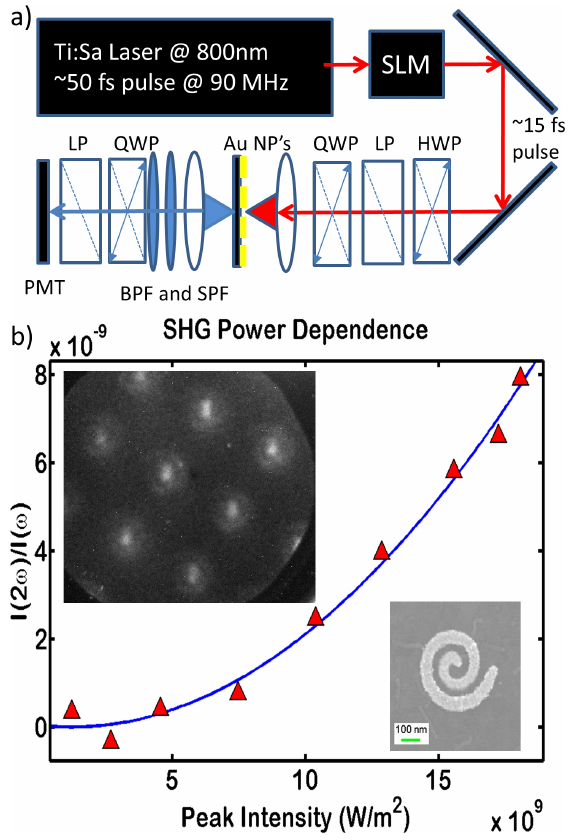
Figure 1: a) Experimental setup used for SHG detection. QWP – quar- ter wave plate. LP – linear polarizer. HWP – half-wave plate. BPF – band pass filter. SPF – short pass filter. SLM – spatial light modu- lator. b) Power dependence of SHG signal on incident power with linear polarization. Blue line – second order polynomial curve